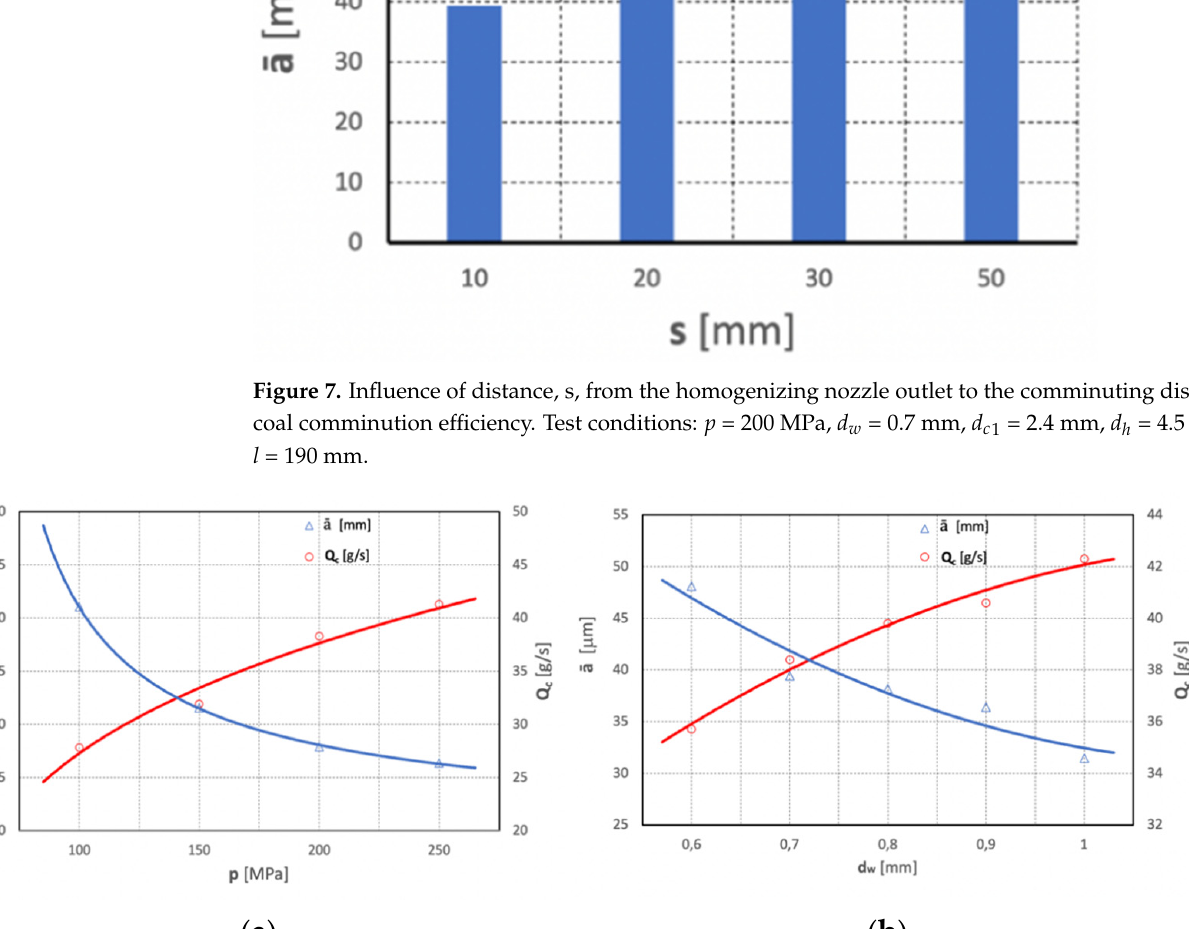
Figure 8. Effectiveness of the comminution process and efficiency of hydro-jet milling for hard coal in relation to: ( a ) pres-